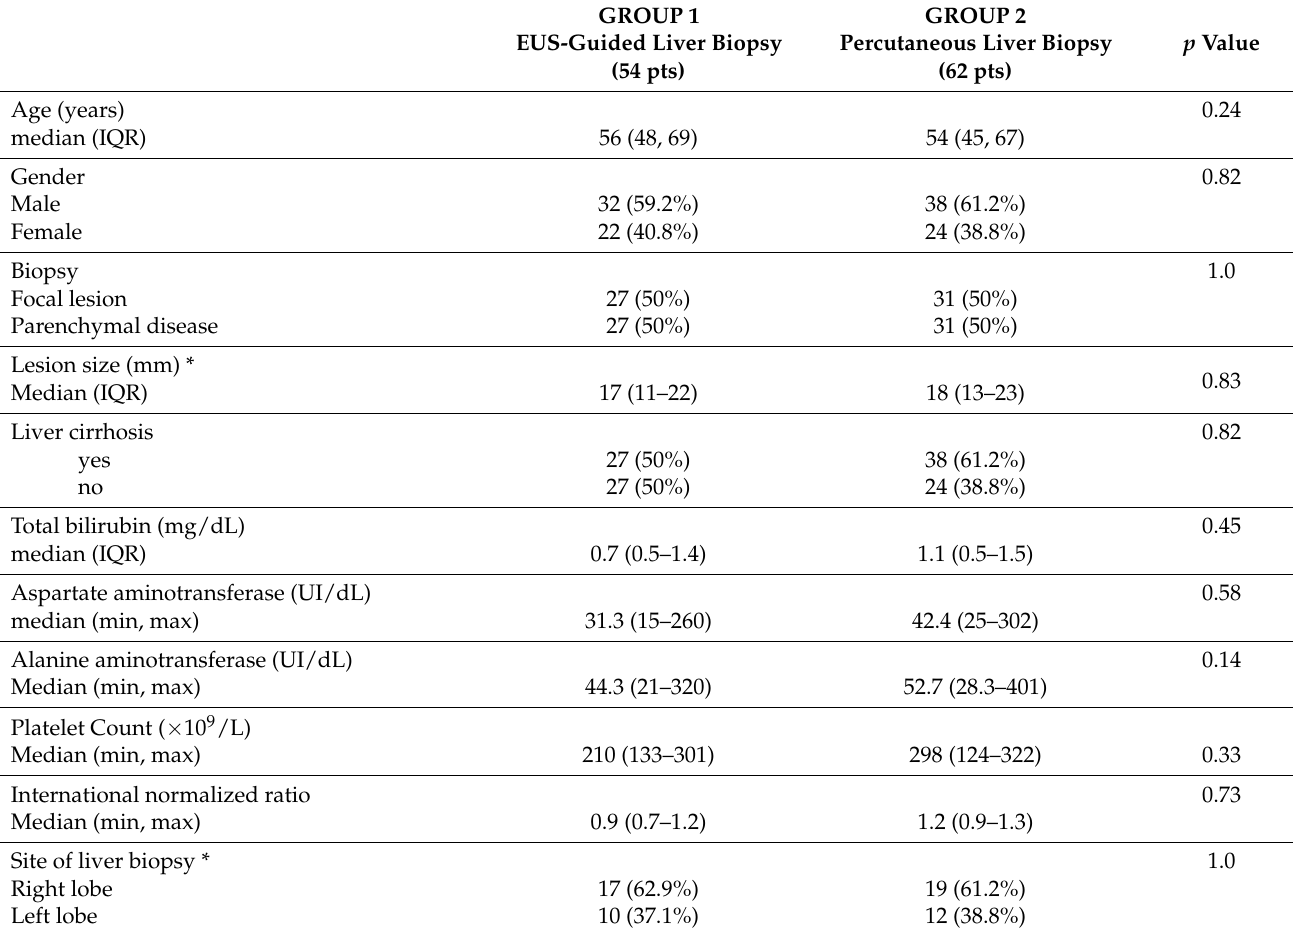
Table 1. Baseline Patient